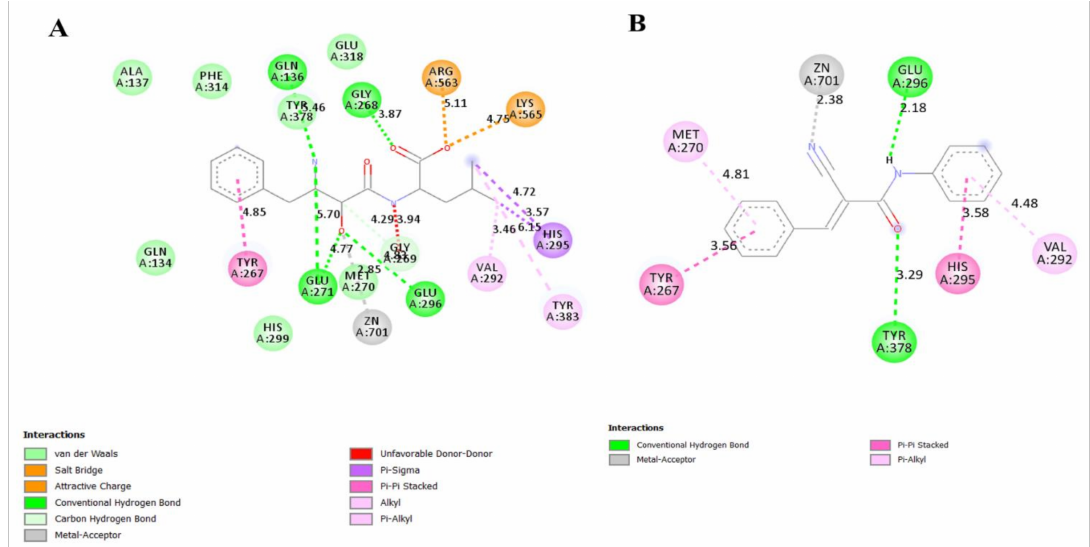
Figure 11. Ligand Bestatin ( A ) and JMPR-01 ( B ) in LTA4 Hidrolase target (PDB ID: